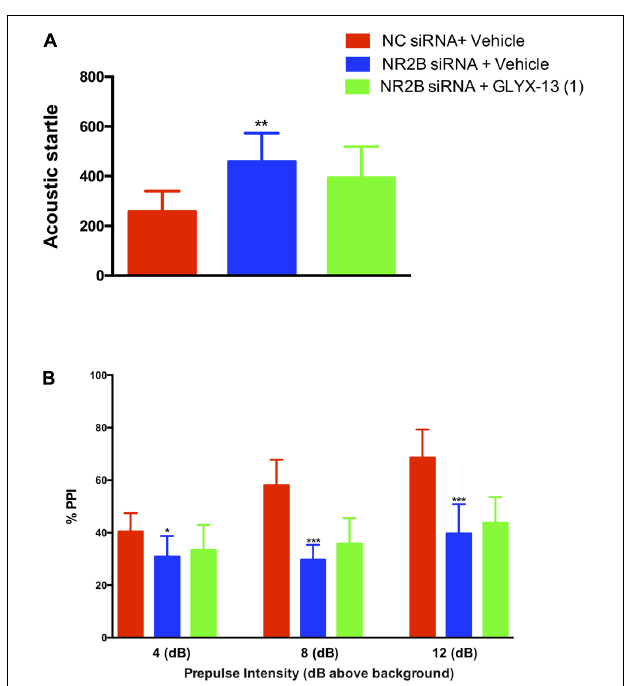
FIGURE 8 | GLYX-13 did not attenuate the NR2B siRNA-induced impairments in PPI of mice. (A) NR2B siRNA significantly increased the startle amplitude. (B) Effect of GLYX-13 on PPI inhibition induced by NR2B siRNA in mice. Data represent the mean ± SEM ( n = 12 per group; ∗ P < 0.05, ∗∗ P < 0.01, and ∗∗∗ P < 0.001, versus the NC siRNA + vehicle-treated group).